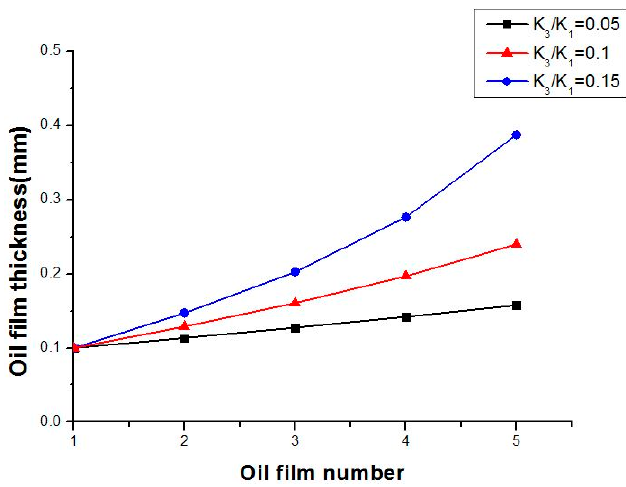
Figure 8. Oil film thickness distribution with different K 3 / K 1 .